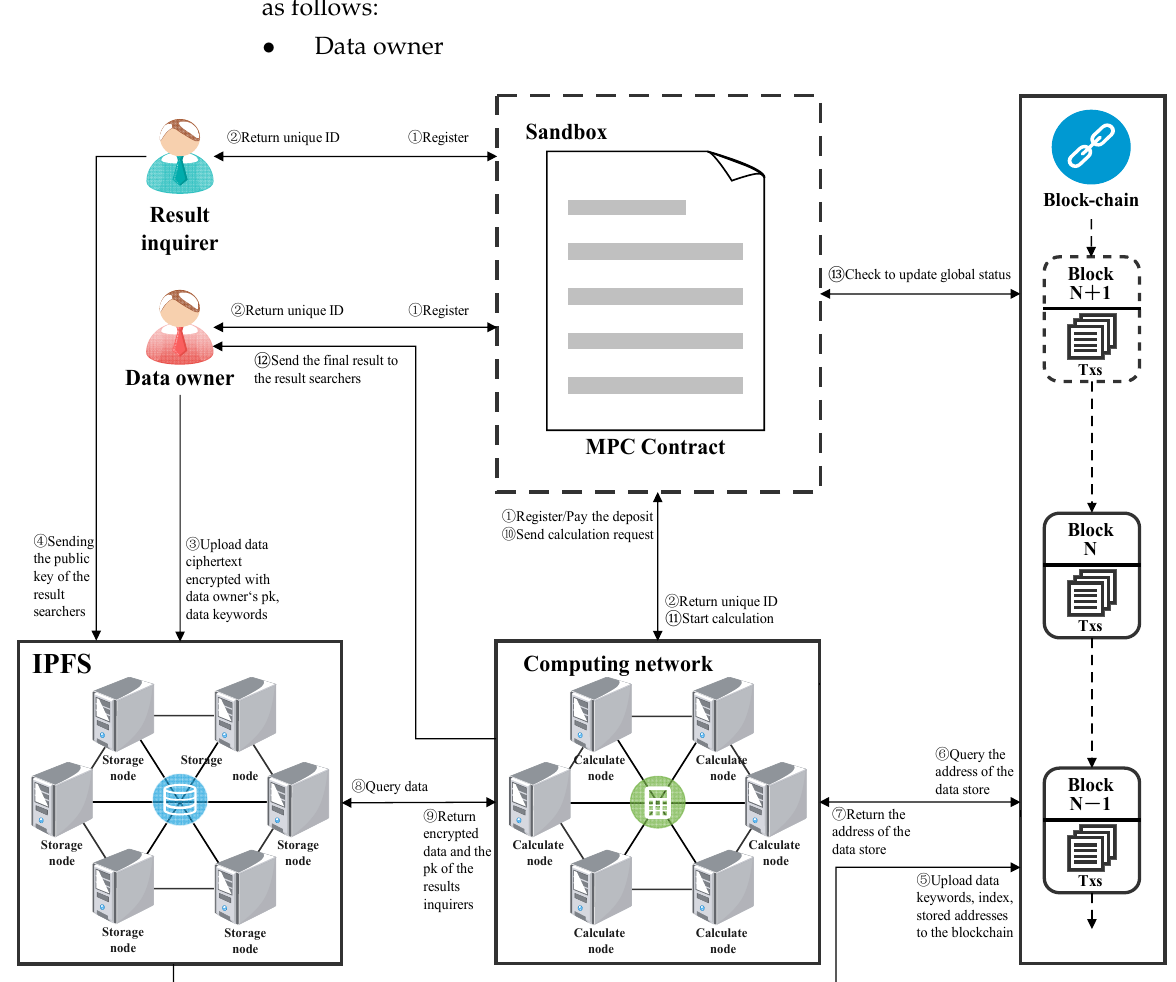
Figure 1. System model diagram.